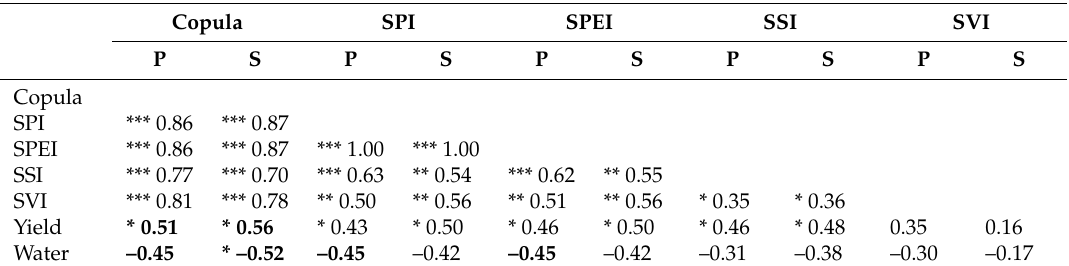
Table 3. Pearson and Spearman correlations between the drought indicators, millet/sorghum yield, and rural water consumption in central-northern Namibia. Copula SPI SPEI SSI SVI P S P S P S P S P S Copula SPI *** 0.86 *** 0.87 SPEI *** 0.86 *** 0.87 *** 1.00 SSI *** 0.81 *** 0.78 ** 0.50 ** 0.56 ** 0.51 ** 0.56 * 0.35 * 0.36 Yield * 0.51 * 0.56 * 0.43 * 0.50 * 0.46 * 0.50 * 0.46 * 0.48 0.35 0.16 Water –0.45 * –0.52 –0.45 –0.42 –0.45 –0.42